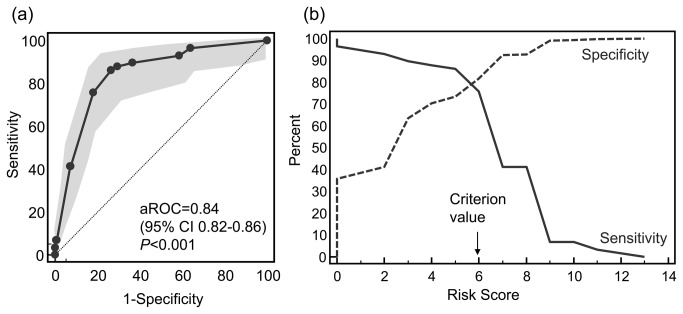
Analysis of risk score discrimination and optimal cut-off for invasive model disease risk.(a) Receiver-operator curve (ROC) analysis plot of the true positives plotted as a function of the false-positives (100-specificity) at different cutoffs of the risk score. Gray bands represent the 95% CI of the plot. The dotted line represents a reference line no discrimination for invasive mold disease (aROC=0.5). The P value is the probability that the aROC differs significantly from aROC=0.5; (b) Plot of sensitivity and specificity versus risk score. The highest sensitivity (true positive rate) and specificity (true negative rate) meet at a score just below 6, suggesting a criterion value of > 6.